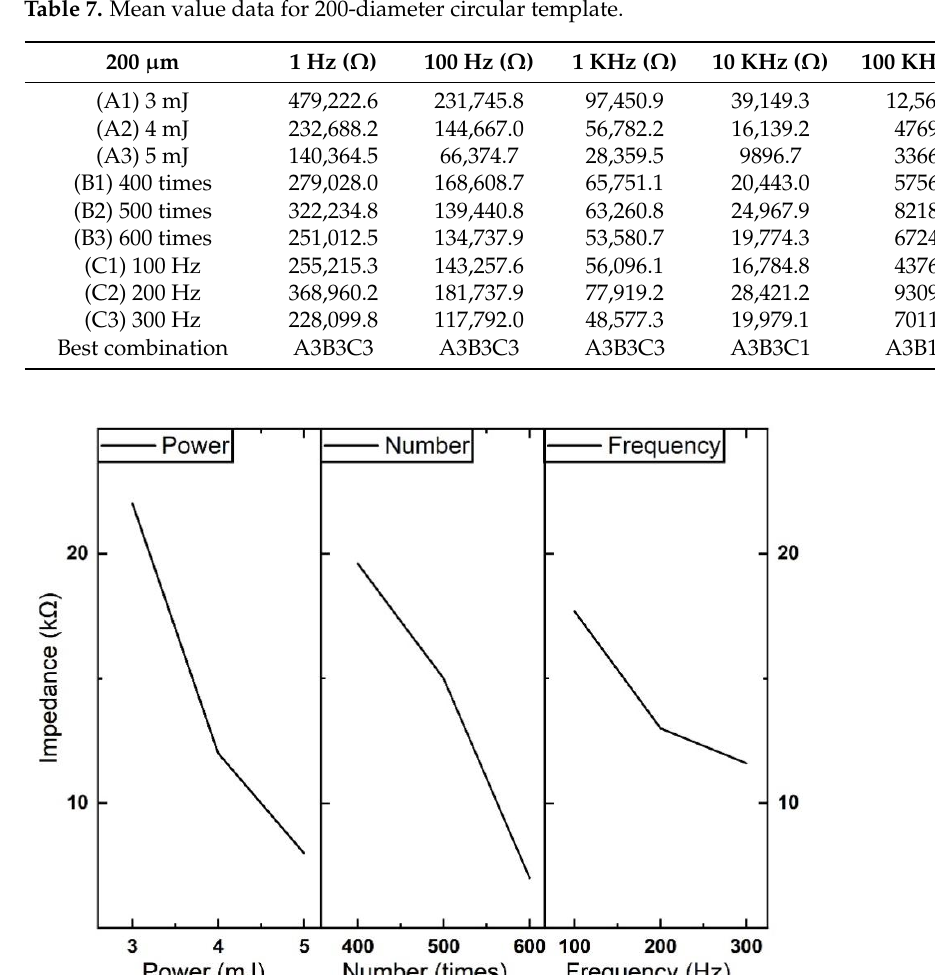
Table 7. Mean value data for 200-diameter circular template.